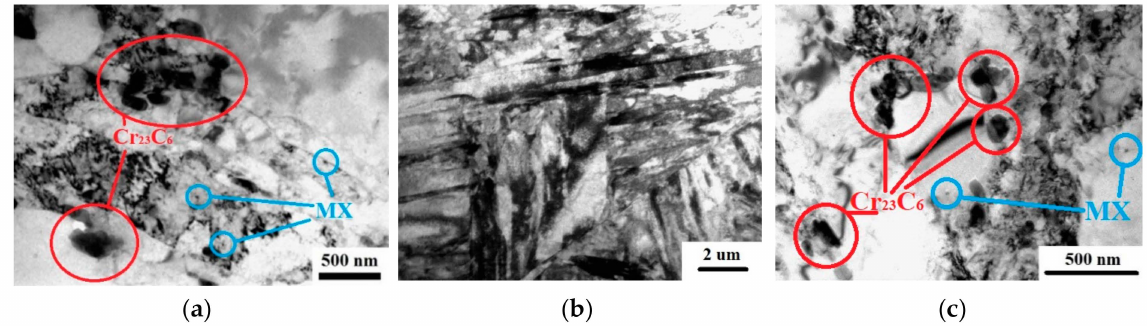
Figure 2. Microstructure of steel: ( a ) initial hot-rolled state, ( b ) oil quenching, and ( c ) tempering. Bright-field TEM